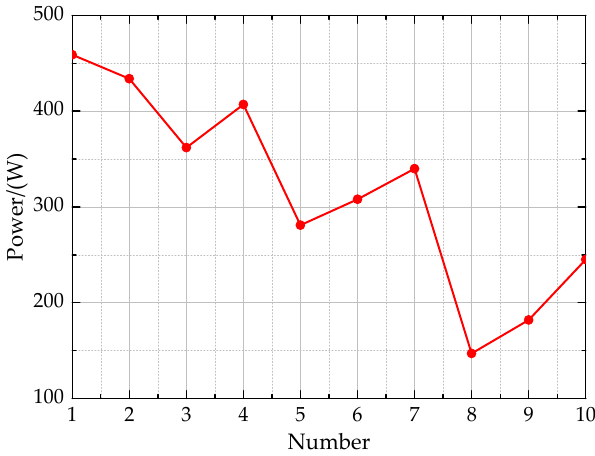
Figure 18. The trend of the corresponding power values in the previous CFD simulation groups.